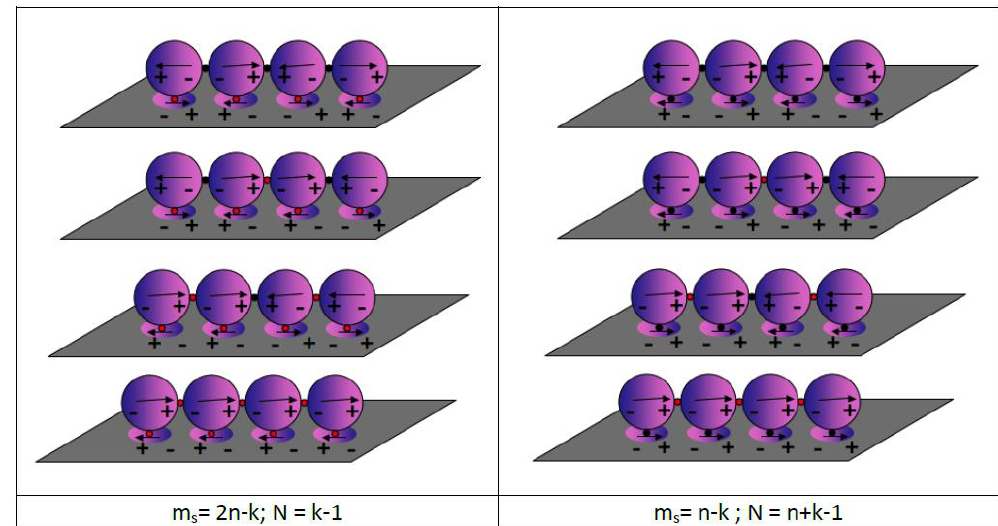
Figure 9. Dipole orientation during four NPs chain on a metallic surface in the case of ( left ) bright and ( right ) dark modes. Potential hot spots are indicated with red spots and nodes are indicated with black spots.